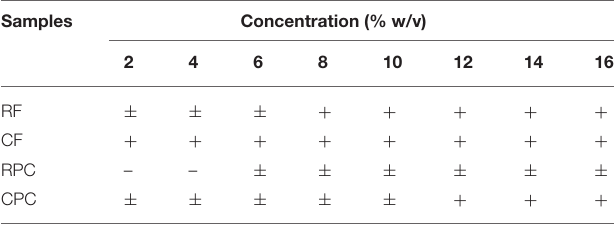
TABLE 3 | Results of gel formation of tepary bean flours (RF and CF) and protein concentrates (RPC and CPC).